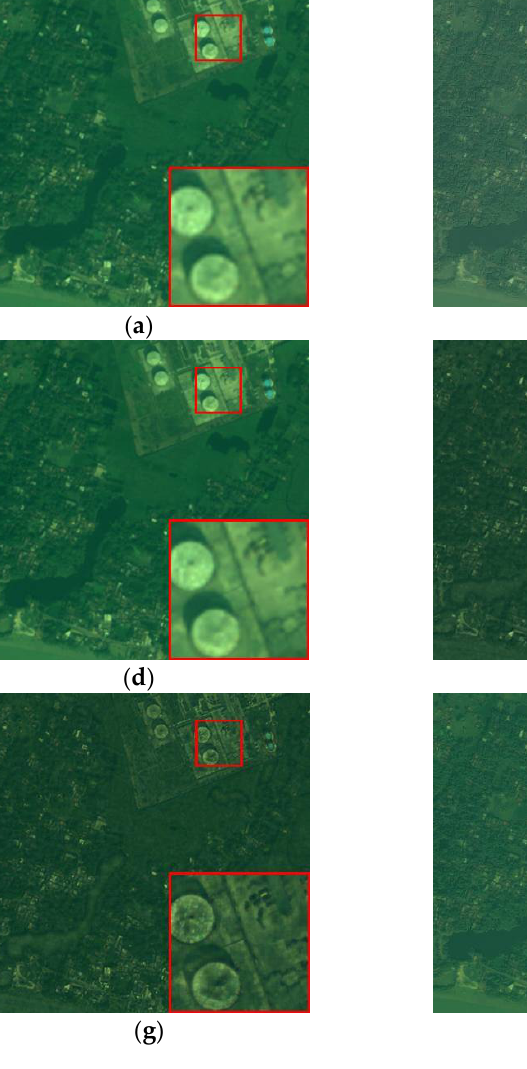
Figure 12. Fused images of QuickBird where ( a ) IHS, ( b ) Wavelet, ( c ) HPF, ( d ) PRACS, ( e ) PNN, ( f ) Fusion-Net, ( g ) SSConv, ( h ) DS-MDNP, and ( i ) Bicubic.